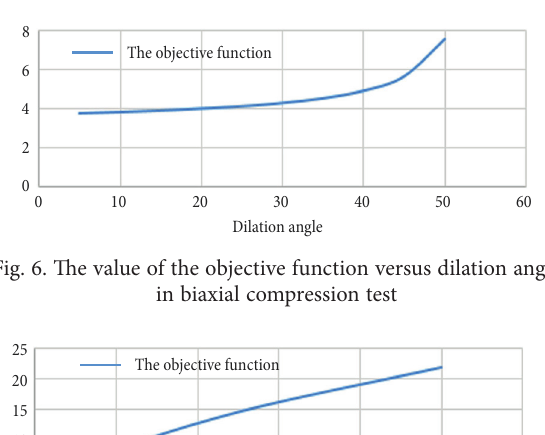
Fig. 5. The value of the objective function versus dilation angle in uniaxial compression test